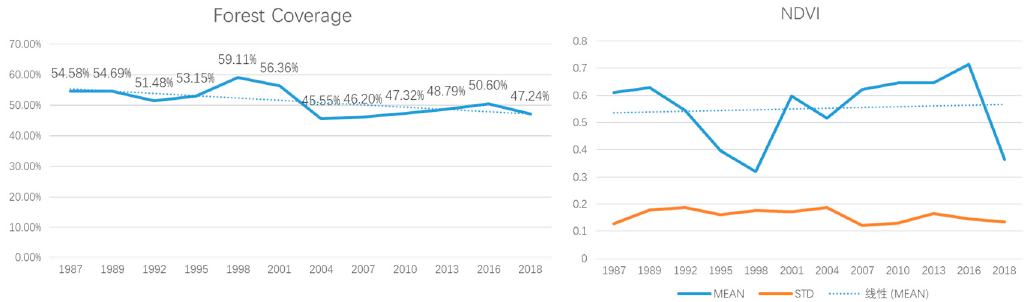
Figure 7. The forest coverage and mean NDVI of Mount Wutai from 1987 to 2018.